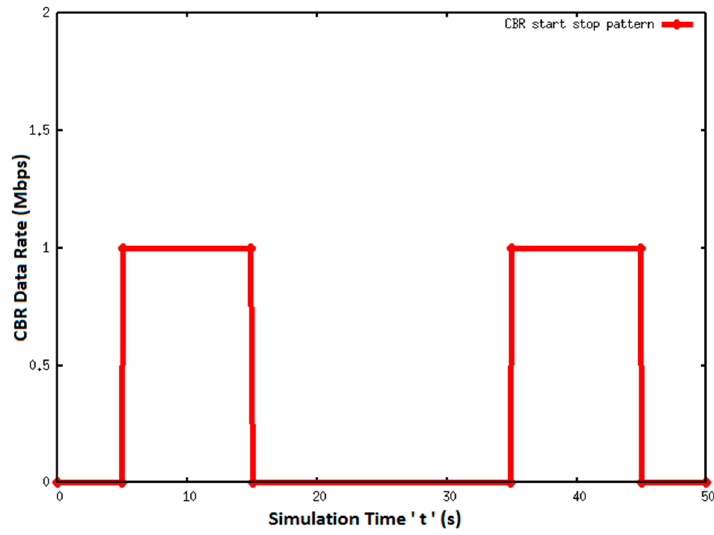
Table 6. Modified Fast TCP parameters.